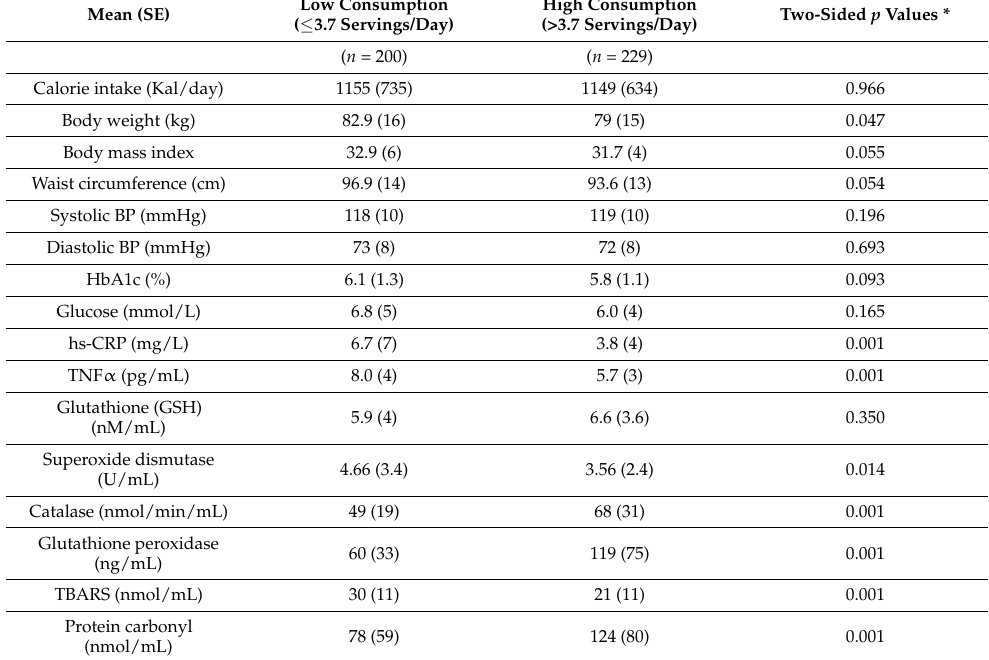
Table 5. Follow-up anthropometrics, BP, lipid and antioxidant contents, and markers of oxidative damage and inflammation in those with a high fruit and vegetable consumption vs. a low